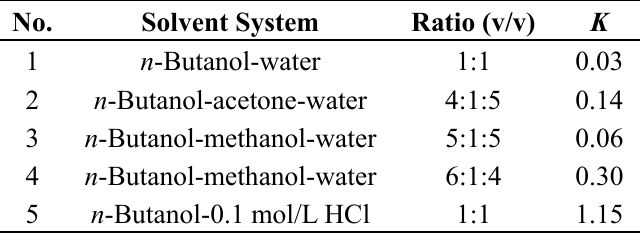
Table 4. K values of HSYA in the different two-phase solvent